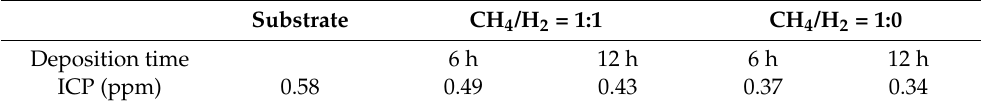
Table 4. Metal ion concentration for the bare and DLC film-coated titanium after 168 h corrosion.